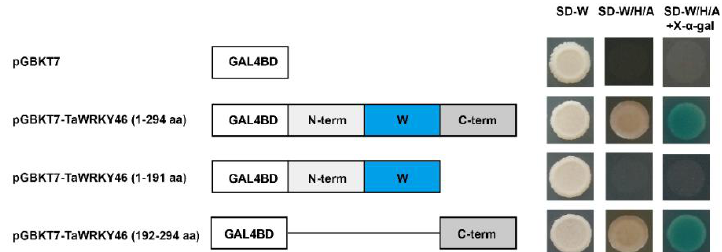
Figure 4. Transcriptional activity assay of TaWRKY46 protein in yeast. A schematic diagram of fused vectors exhibiting the truncated segments of TaWRKY46 that were fused to the vector pGBKT7 . The transformants were incubated on the SD-W, SD-W/H/A, and SD-W/H/A with X- α -gal medium.